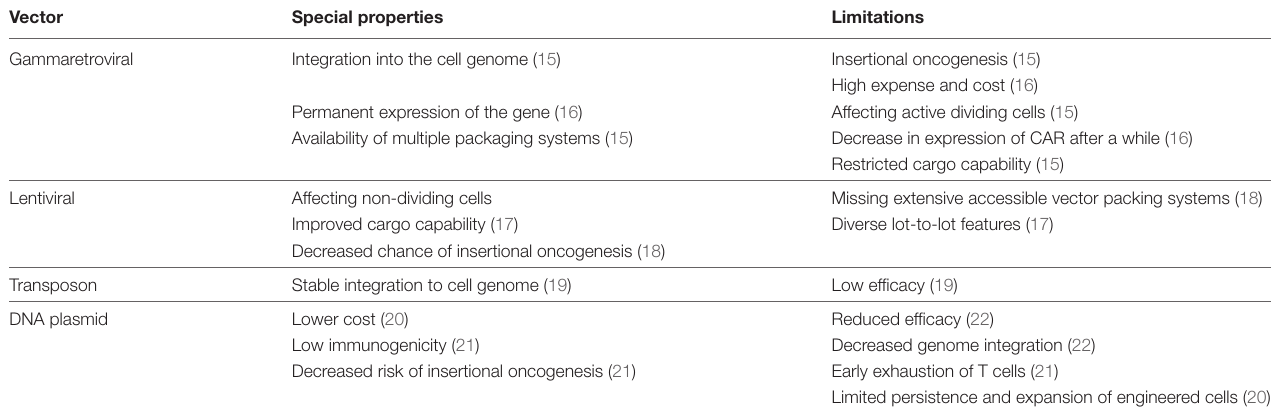
TAble 1 | Characteristics and limitations of each vector utilized for chimeric antigen receptor (CAR) transgene transduction.